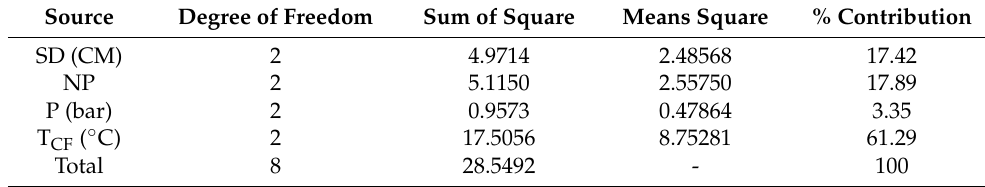
Table 7. ANOVA for C d .